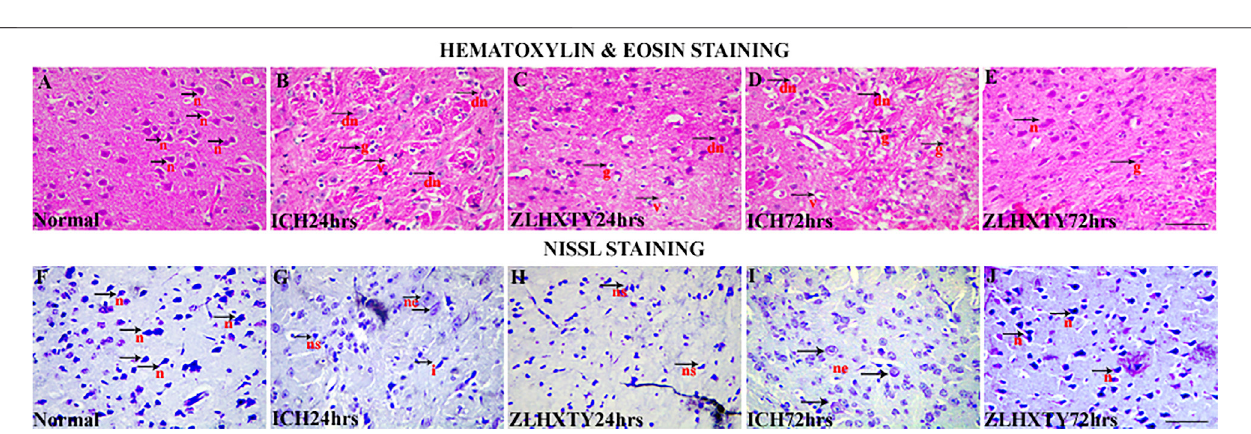
FIGURE3| HEandNisslstainingofbrainshowingneuroprotectiveeffectofZLHXTYtreatmentafterICH.HEstaining (A – E) ,showing (A) normal,blackarrowswith n-normal pyramidal neurons and intact parenchyma; (B,D) 24 and 72 h ICH pathological changes, black arrows with v-vacuolation and parenchymal loss, dn-neuronal shrinkageand degeneration, g-reactive gliosis; (C,E) — 24and 72 h ZLHXTY-HD treatment, improving in fl ammatory histopathological changeswithmore intact neuropil and less vacuolation, less neuronal damage, less number of glial cells and in fl ammation. Nissl staining (F – J) , (F) normal, black arrows indicate normal nissl bodies; (G,I) 24 and 72 h ICH injury showing gradual and obvious loss of nissl substance, black arrowhead with ne-neuronal swelling and edema, ns-neuronal shrinkage with condensation of nissl substance, i-irregular shaped degenerating neuron; (H,J) 24 and 72 h ZLHXTY-HD treatment, showing evident increase in nissl substance in neurons. 50 µm scale bar corresponds to 400 × magni fi cation.